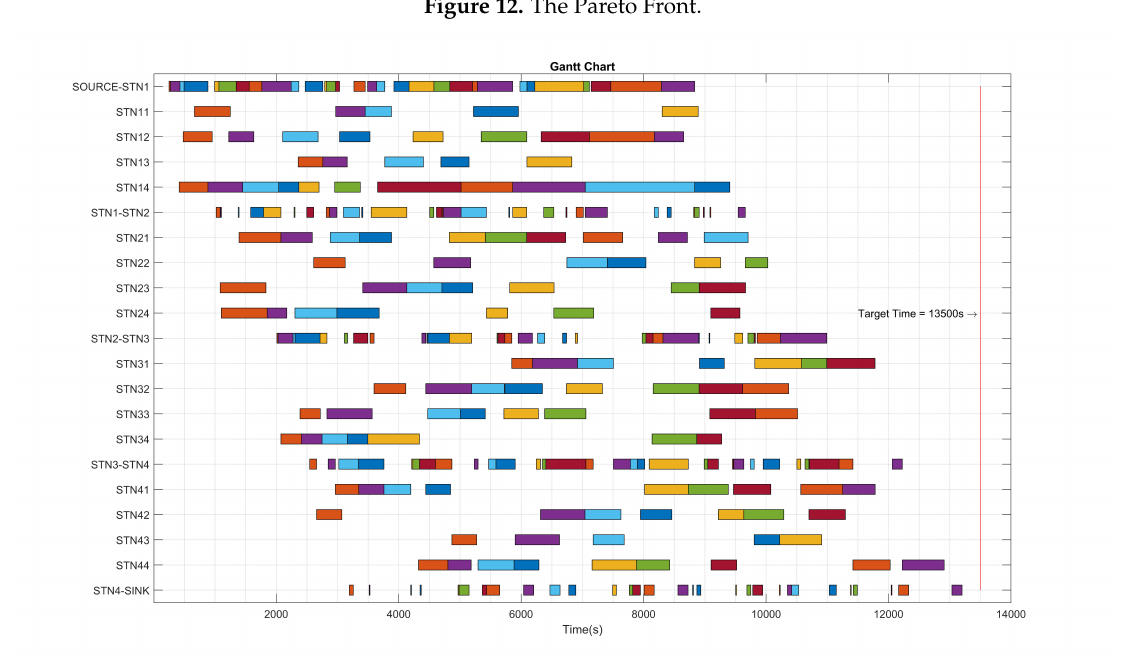
Figure 13. Gantt Chart (Normal/planned